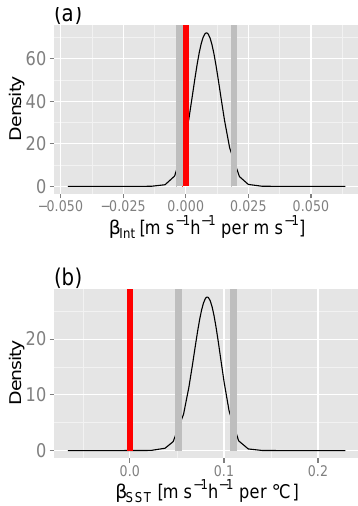
Figure 8. Posterior densities, with all other β terms held constant. (a) Modeled density of mean intensification changes per 1ms − 1 increase in mean intensity. (b) Modeled density of mean intensifica- tion changes per 1 ◦ C increase in mean SST. The red line represents the x = 0 line (i.e., no effect). The gray lines represent the 95% CI.